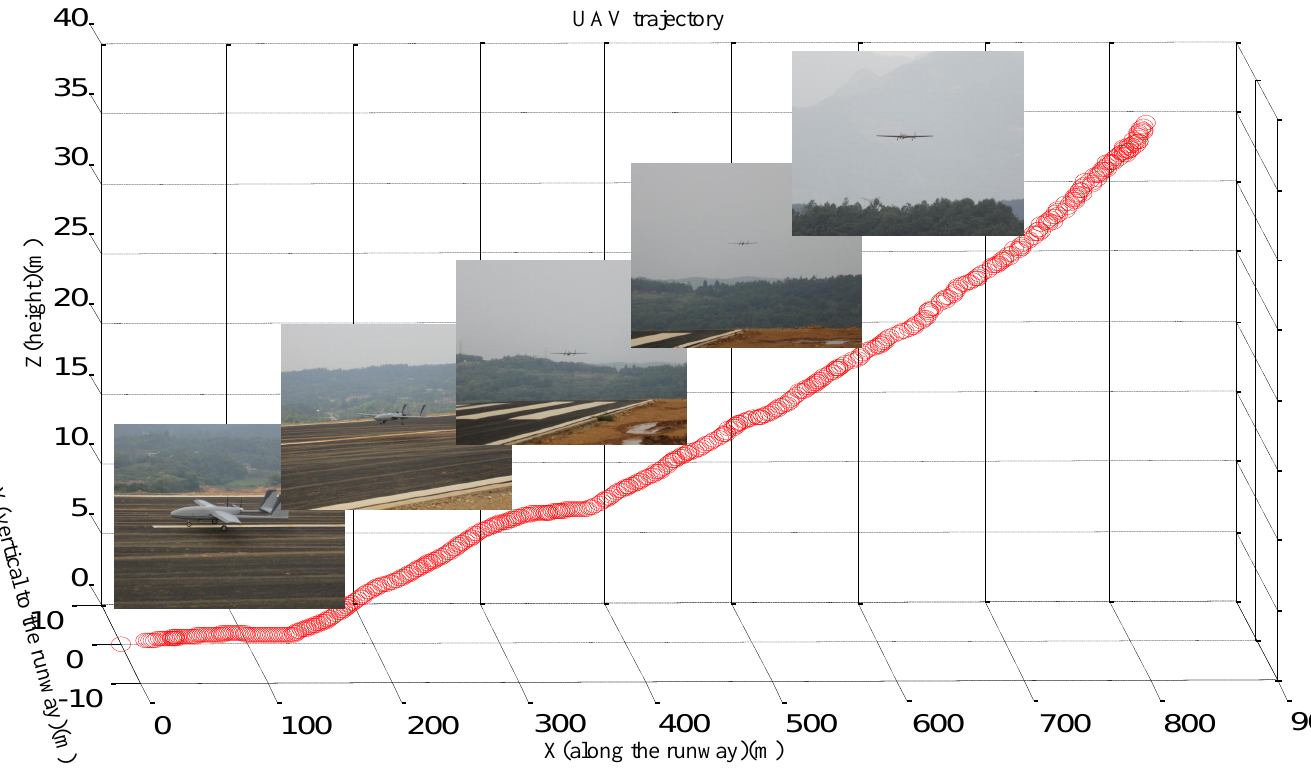
Figure 11. Landing trajectory away from 800